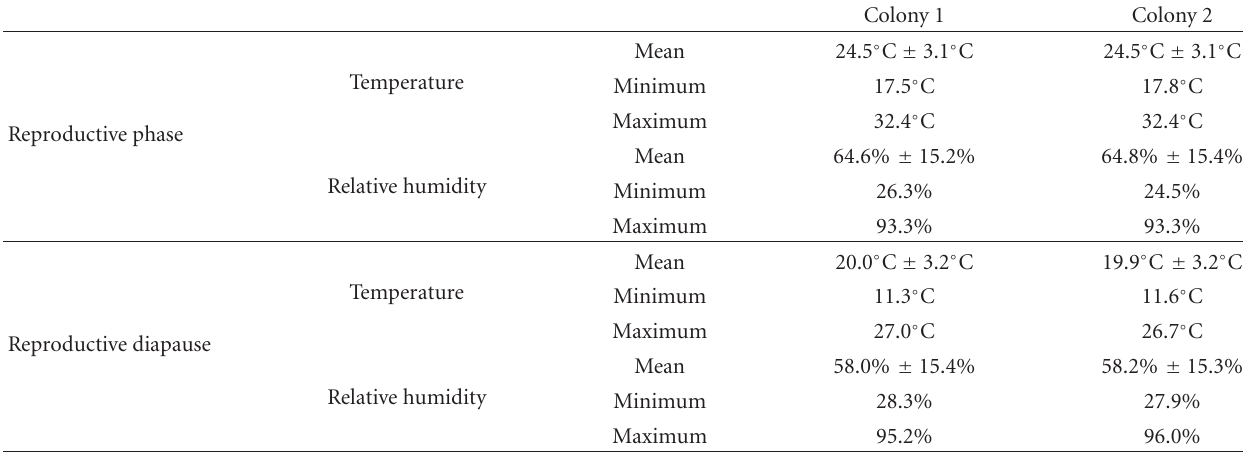
Table 1: Mean, minimum, and maximum temperatures ( ◦ C) and relative humidity (%) during the reproductive phase and reproductive